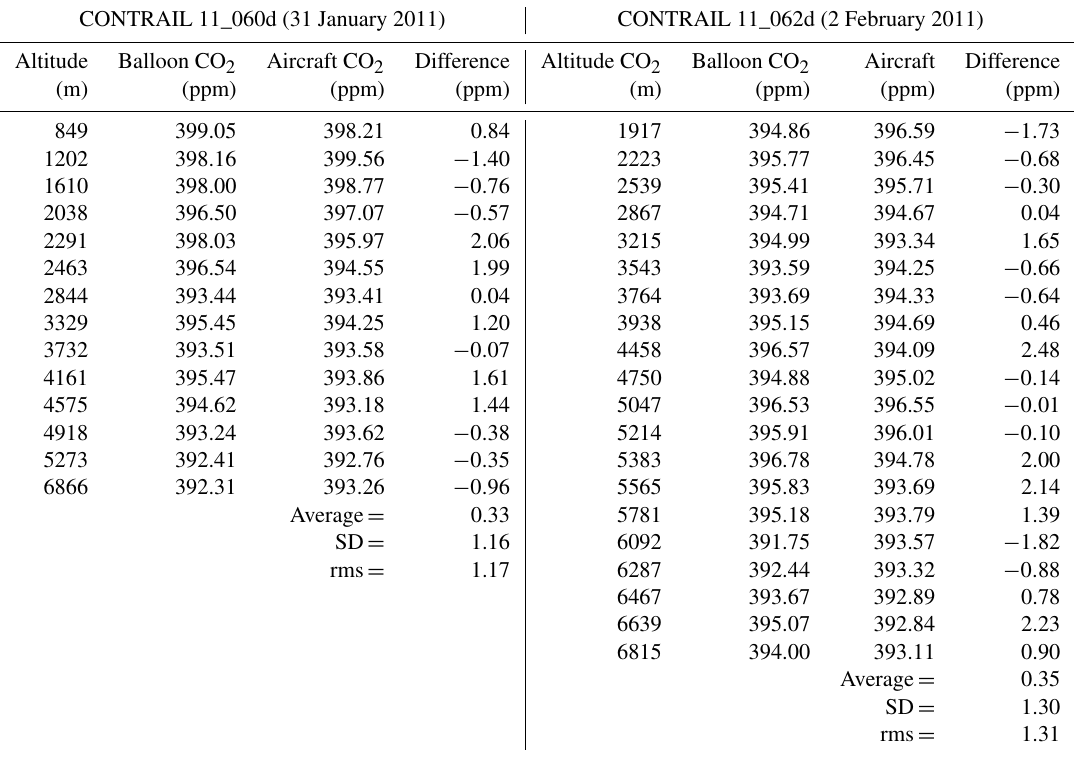
Table 3. Comparisons of the CO 2 mole fractions between the balloon CO 2 sonde measurements on 31 January and CONTRAIL aircraft CME on 31 January (11_060d) and between the CO 2 sonde on 3 February and CONTRAIL on 2 February (11_062d) up to the altitude of 7km. The annotations are the same as Table